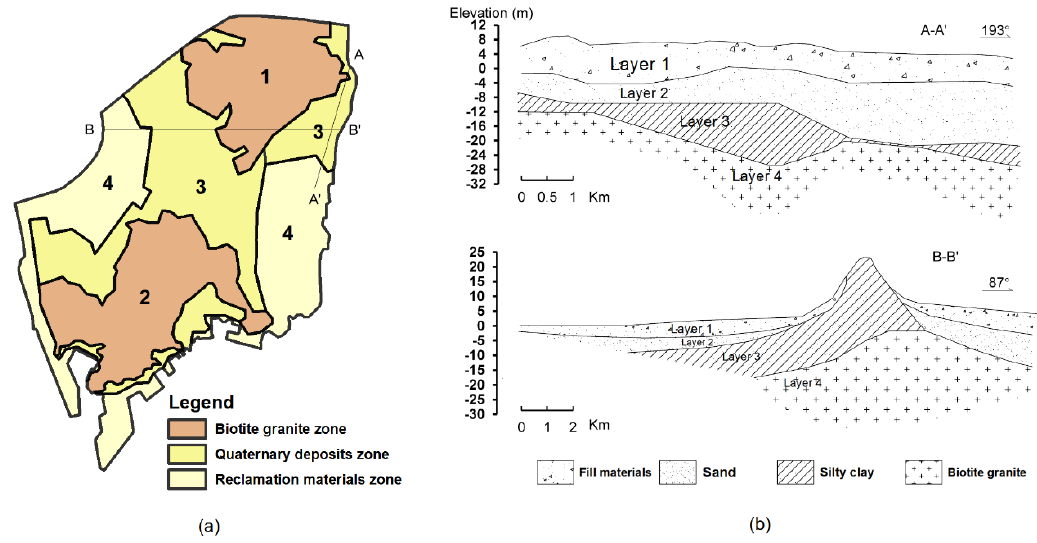
Figure 2. The geological division (Zones 1–4) in the study area ( a ) and the two typical cross sections of geological formation ( b ).